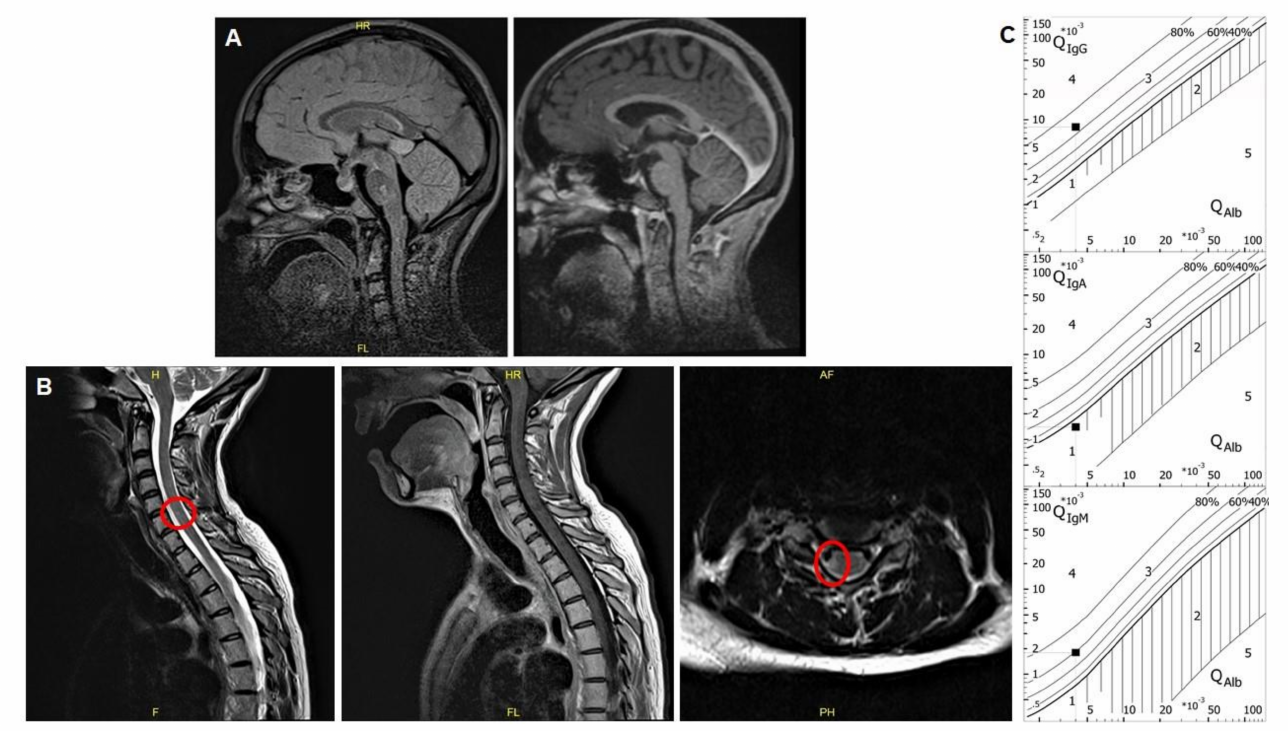
Figure 1. ( A ) T1w sagittal native and after contrast enhancement. Pontine signal hyperintensity without contrast enhance- ment. A further lesion was detected left temporal (not shown), without contrast enhancement as well. ( B ) T2w sagittal and transversal as well as T1w after contrast enhancement. Right-sided signal hyperintensity without contrast enhancement. ( C ) Results of cerebrospinal fluid investigations depicted in the typical Reibergram with intrathecal immunoglobulin G and M synthesis. 1 = no blood brain barrier dysfunction. 2 = blood brain barrier dysfunction with elevated albumin. 3 = elevated albumin and intrathecal immunoglobulin synthesis. 4 = intrathecal immunoglobulin synthesis only. 5 = incorrect